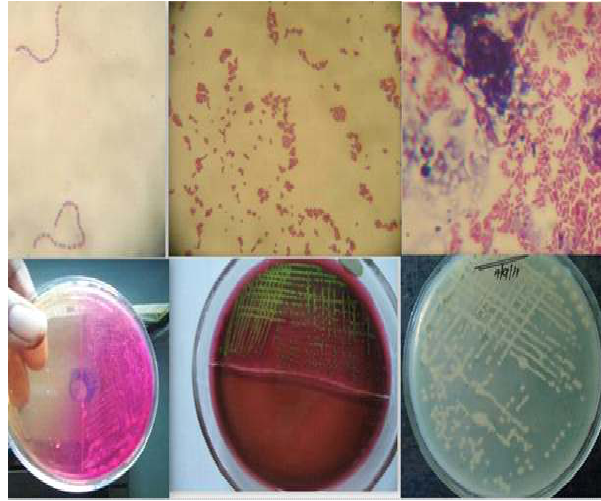
Figure-2. From top left to right: S